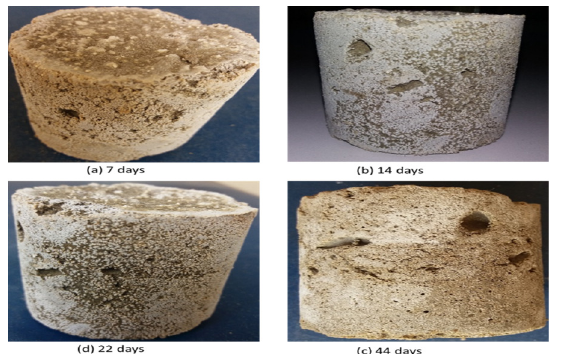
Fig. 11: Comparison of the sides of Bacterial + Calcium Lactate Sample